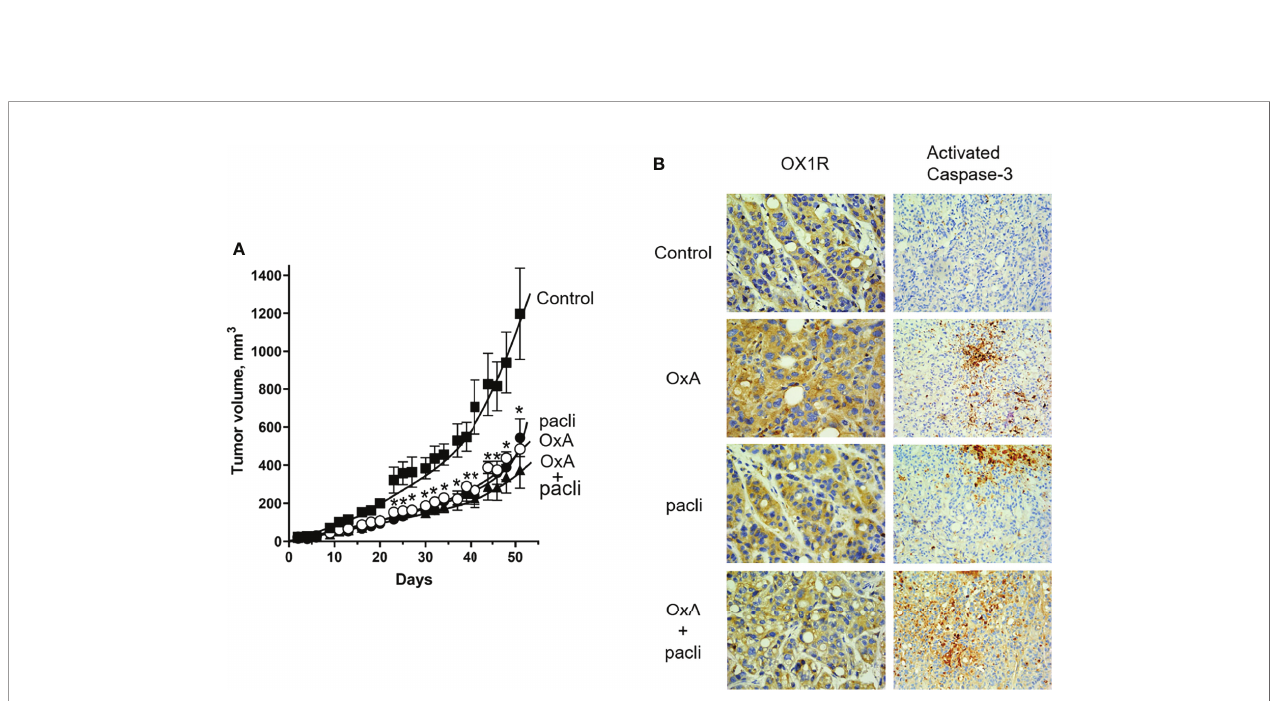
FIGURE 4 | Preclinical study and histological analysis of anti-tumoral effect of OxA and Nab-paclitaxel. (A) Impact of three injections/week of 100 µg OxA, 230 µg Nab-paclitaxel, or 100 µg OxA plus 230 µg Nab-paclitaxel on volume of tumors developed from subcutaneously xenografted ASPC-1 cells in nude mice. The tumor development was measured with a caliper. (B) Determination of OX1R expression and caspase-3 activation by histologic immunostaining in xenografted AsPC-1 resected tumors from mice treated with PBS (control), OxA (OxA), Nab-paclitaxel (pacli), or OxA plus Nab-paclitaxel (OxA + pacli). Magni fi cation was 40× (OX1R expression) and 20× (caspase-3 activation). Data were the means ± SEM of six tumors in each group.